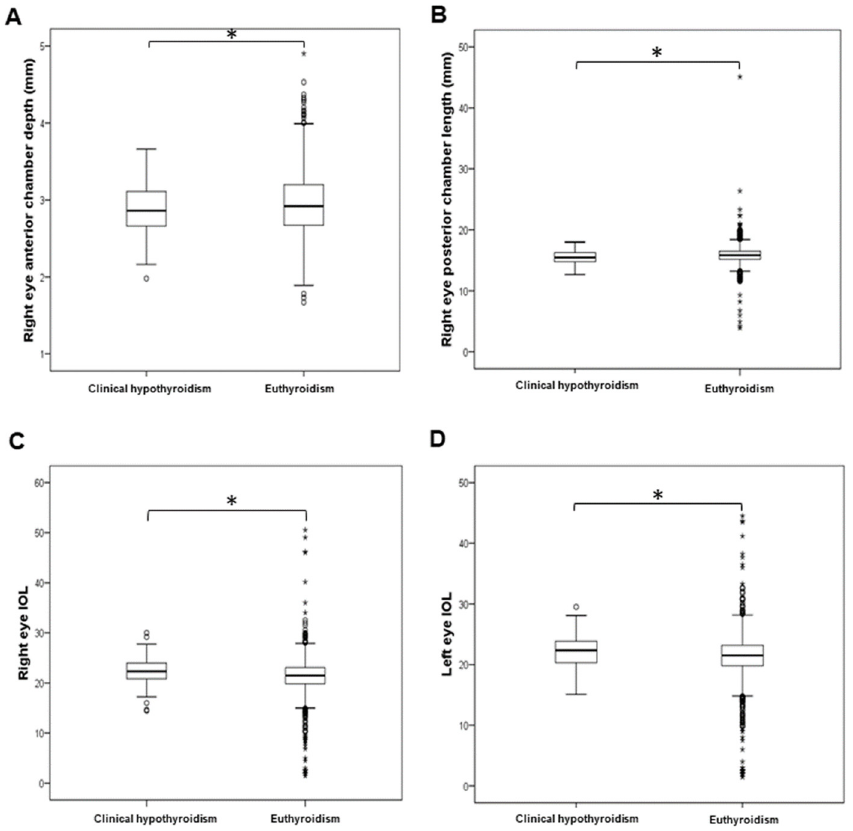
Figure 2. Comparison of ocular parameters between individuals with clinical hypothyroidism and euthyroid individuals. ( A ) Right eye anterior chamber depth, ( B ) right eye posterior chamber length, ( C ) right eye IOL, ( D ) left eye IOL. * p < 0.05.